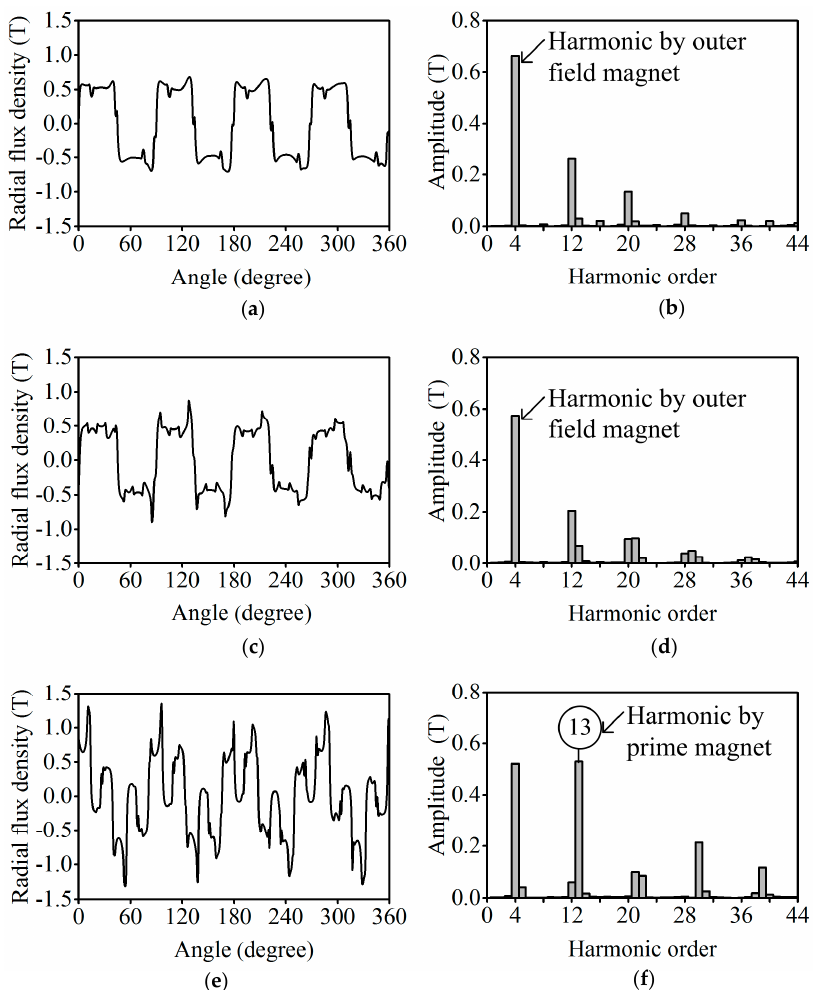
Energies 2017 , 10 , 2048